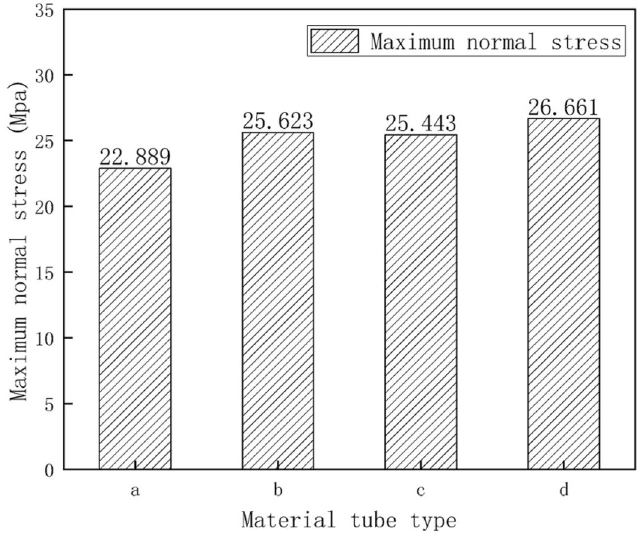
Figure 7. Histogram of normal skeleton stress under uniform snow load condition.